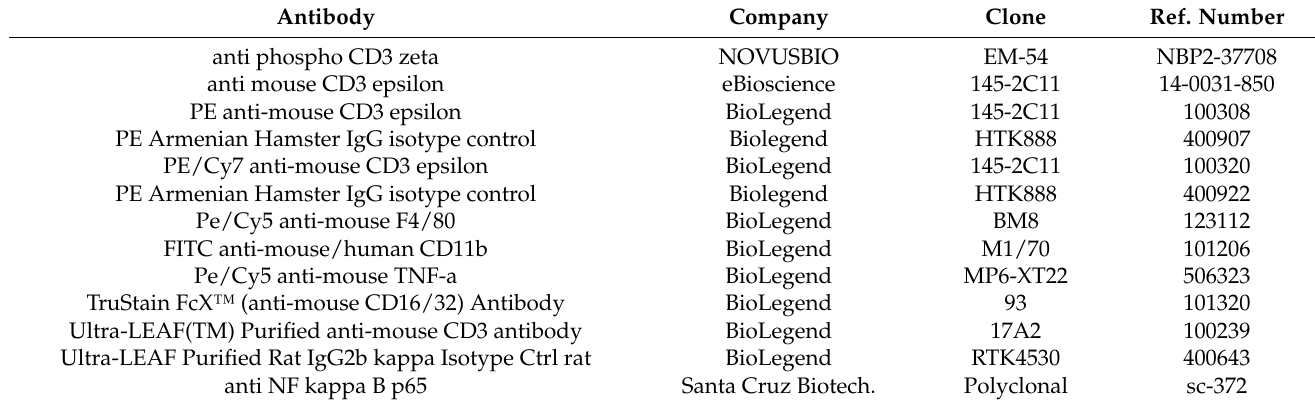
Table A1. Information on the antibodies used in this